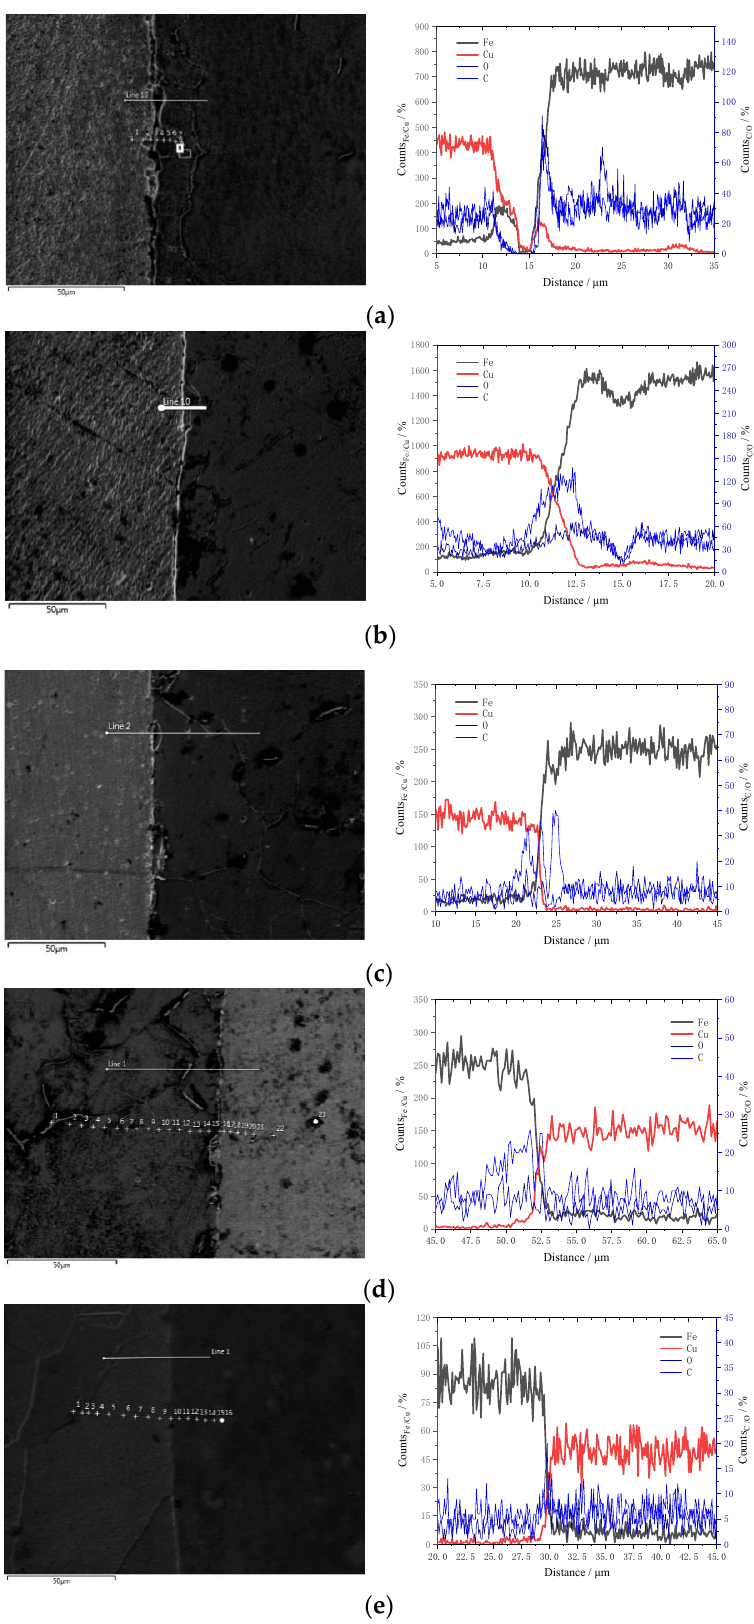
Figure 4. Line scan results of the bounding areas at different casting temperatures. ( a ) 1100 °C; ( b )